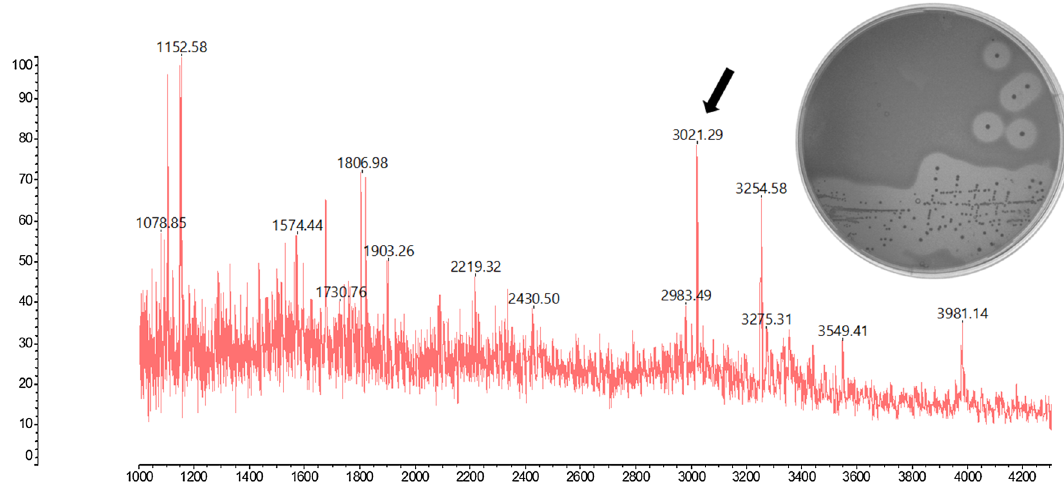
Figure 1. Detection of the 3,021.29 Da gallocin D2 peptide by MALDI-TOF MS from colonies on a plate. Inset shows the antimicrobial activity of S. gallolyticus LL009 against L. bulgaricus